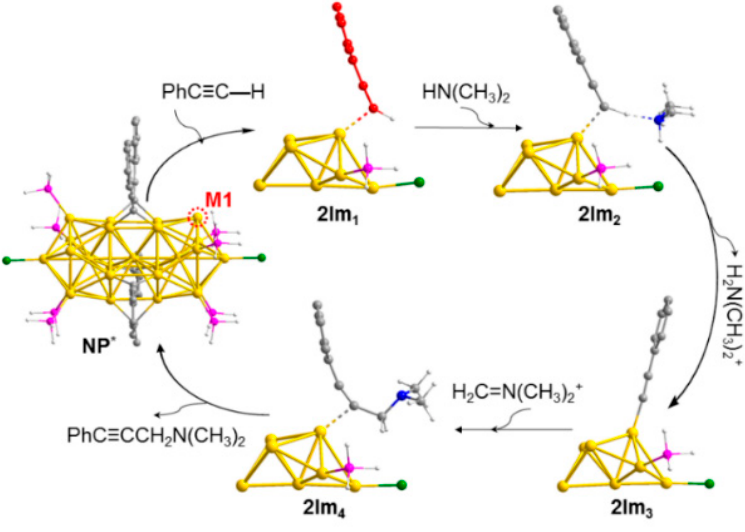
Figure 9. Proposed mechanism for the [Au 25 (PH 3 ) 10 (PA) 5 Cl 2 ] 2 + -catalyzed A 3 -coupling reaction. Reproduced with permission from [62]. Elsevier, 2016.